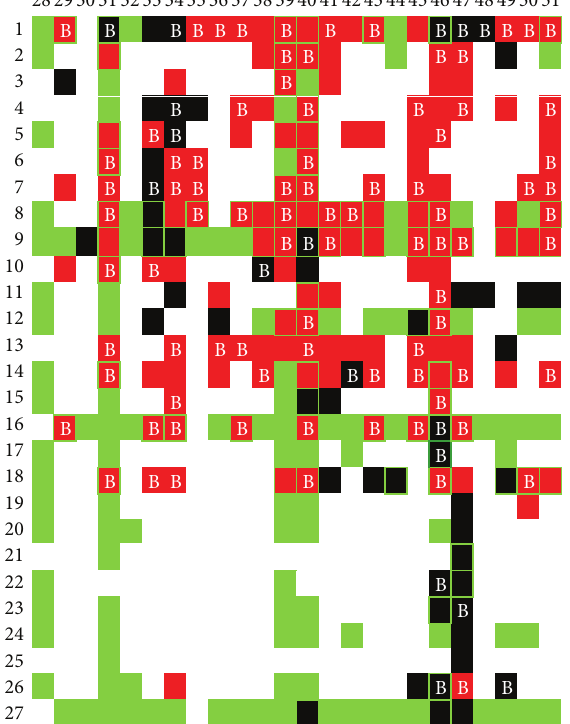
Figure 1: A diagram of the crosses conducted in the present trial (black) with the hybrids tested in regional assays (red). Hybrids selected for the test population are shown in green. Hybrids selected in the regional assay are represented by the letter B. The hybrids evaluated in the regional assay that were selected from the test population are outlined in